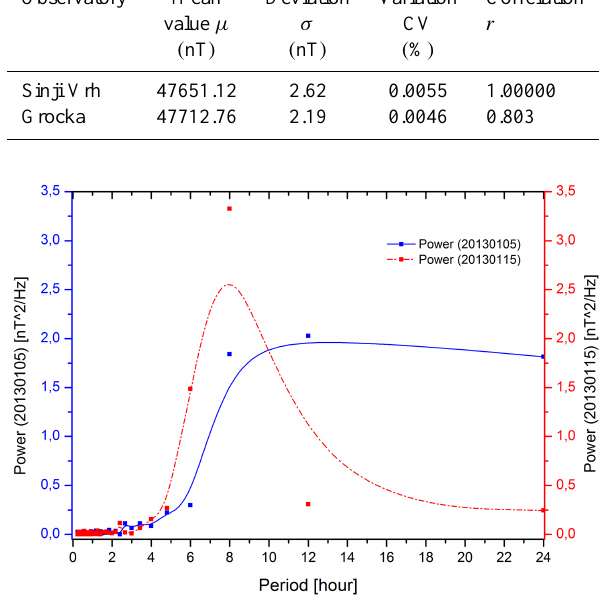
Figure 7. The power spectra of the local geomagnetic field at the Observatory during the snowstorm crossing on 15 January 2013 (20130115) and during the geomagnetic quiet day on 5 Jan- uary 2013